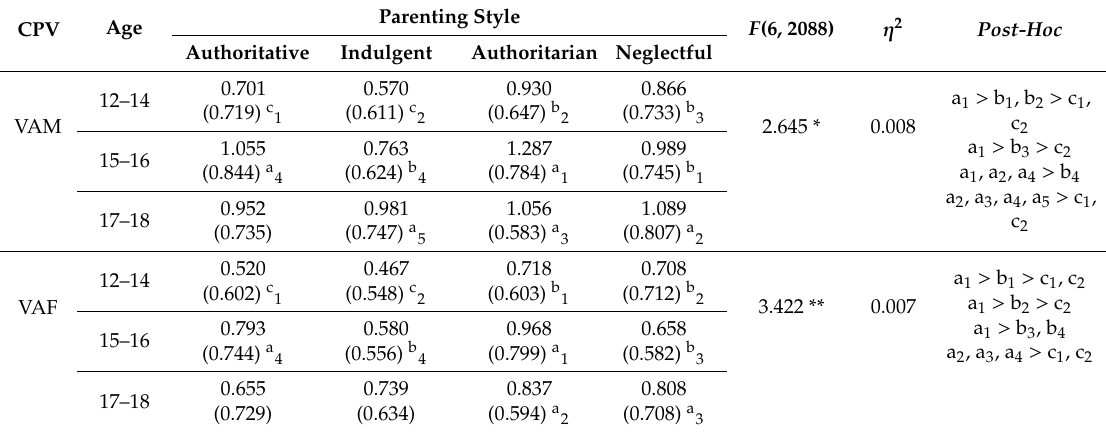
Table 4. Means, standard deviations, and post-hoc comparisons between parenting styles, age, and dimensions of CPV (VAM, VAF).